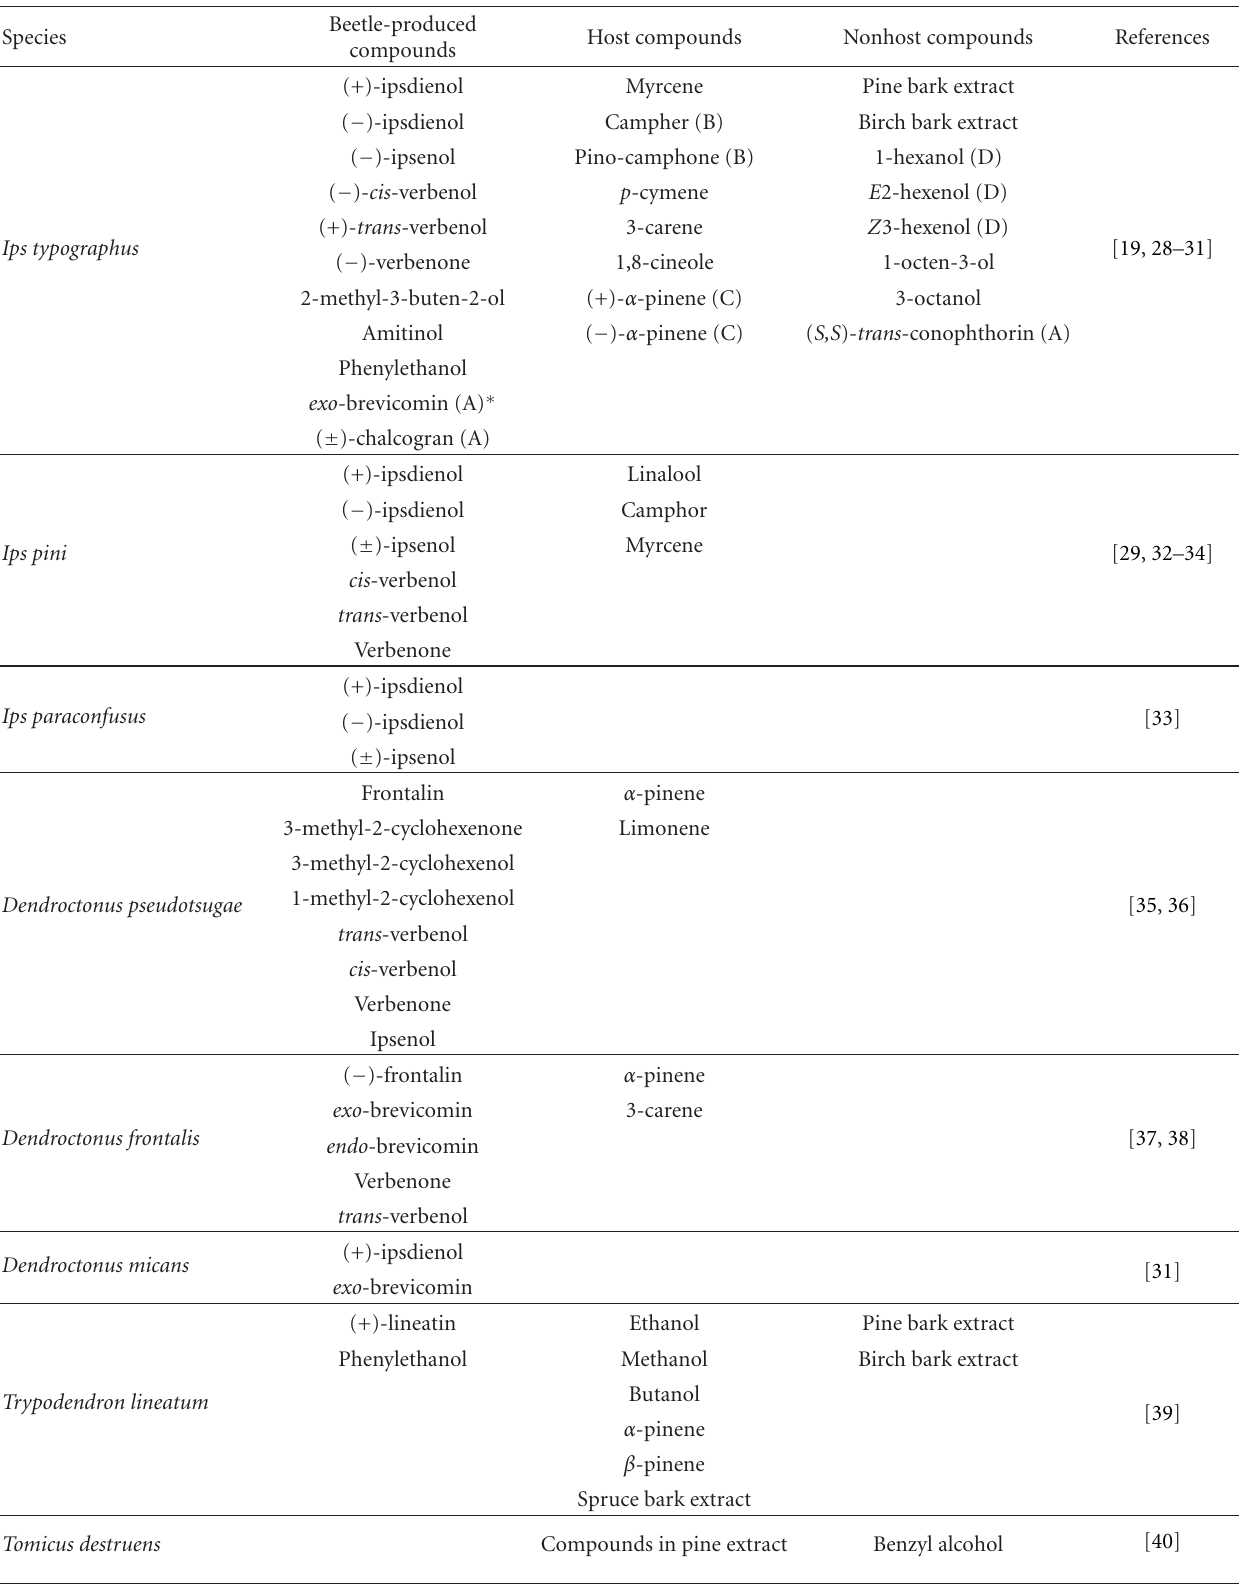
Table 1: Compounds from di ff erent ecological sources that elicit strong responses in olfactory receptor neurons in eight species of Scolytinae.